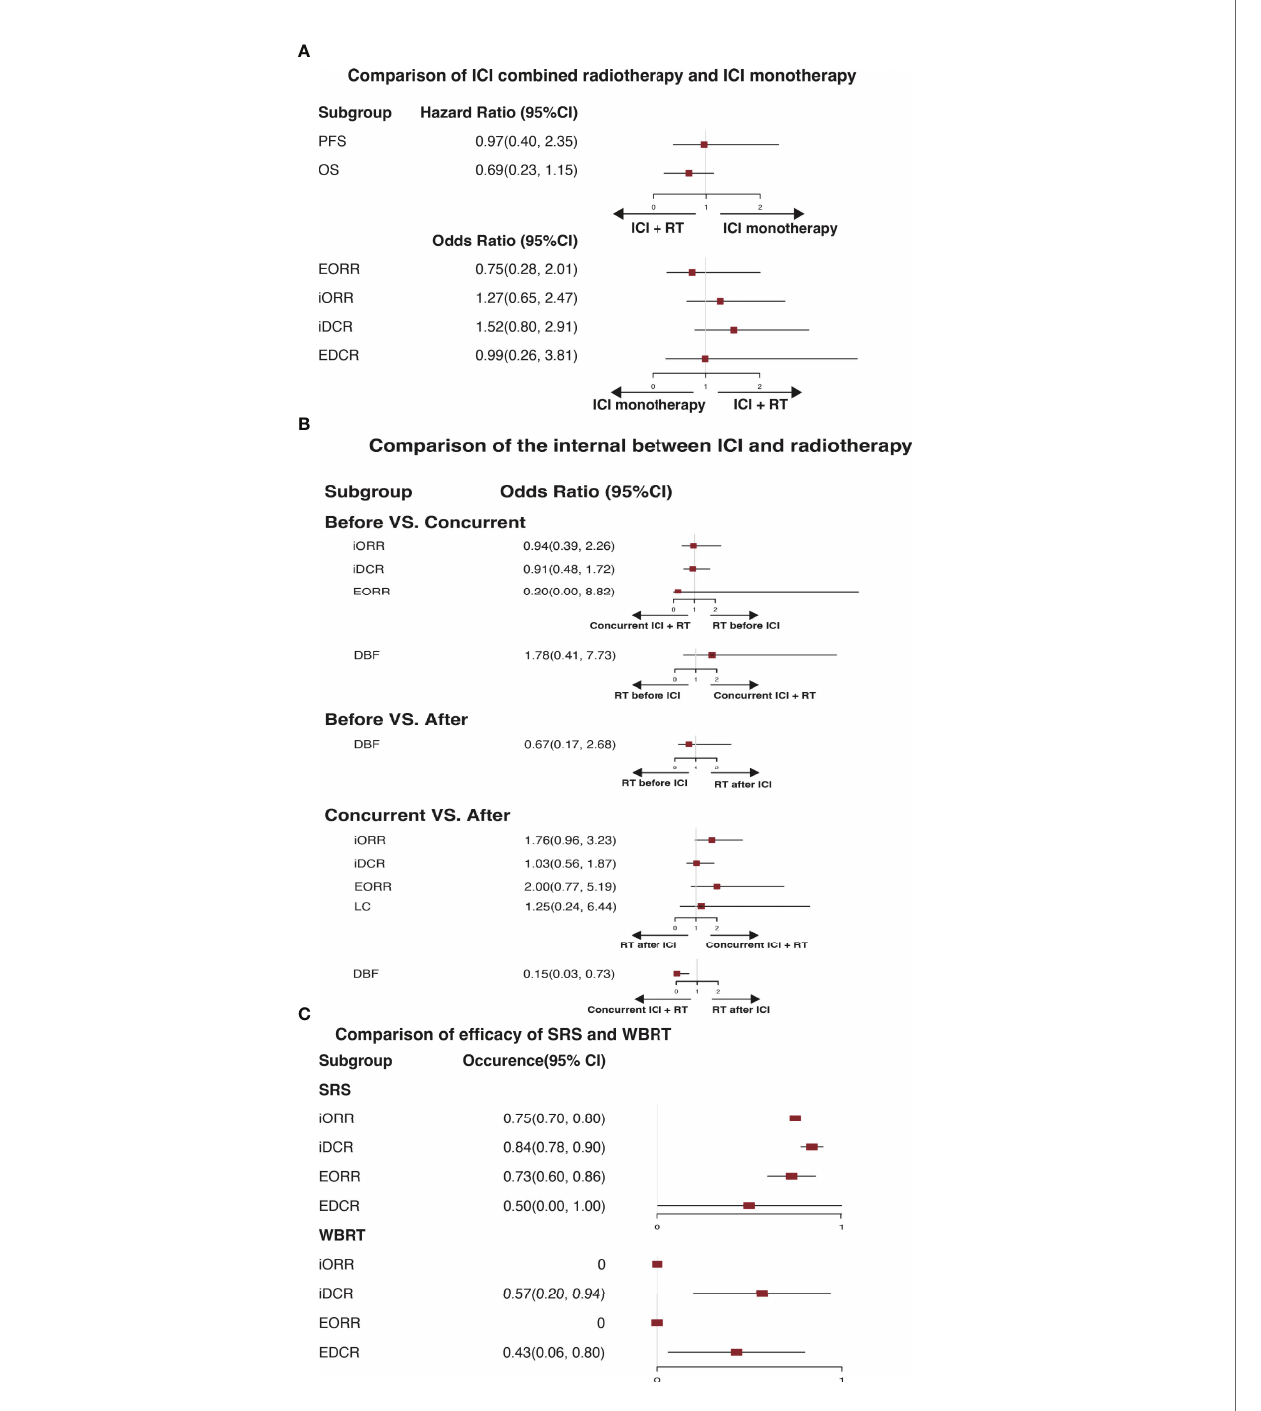
FIGURE 4 | (A) Illustrates a pooled therapeutic result in comparison of immune checkpoint inhibitor monotherapy and immune checkpoint inhibitor combined radiotherapy. (B) Illustrates a pooled therapeutic result of comparison among radiotherapy before immune checkpoint inhibitor, concurrent immune checkpoint inhibitor combined radiotherapy, and radiotherapy after immune checkpoint inhibitor. (C) Illustrates a pooled result in comparison of stereotactic radiation surgery and whole-brain radiation therapy. ICI, immune checkpoint inhibitor; RT, radiotherapy; SRS, stereotactic radiation surgery; WBRT, whole-brain radiation therapy; PFS, progression-free survival. OS, overall survival; iORR, intracerebral objective response rate; iDCR, intracerebral disease control rate; EORR, extracranial overall response rate; EDCR, extracranial disease control rate; DBF, distant brain failure; LC, local